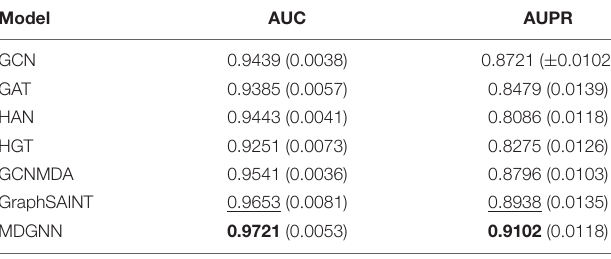
FIGURE 3 | Receiver operating characteristic (ROC) curves of different models under the first-fold